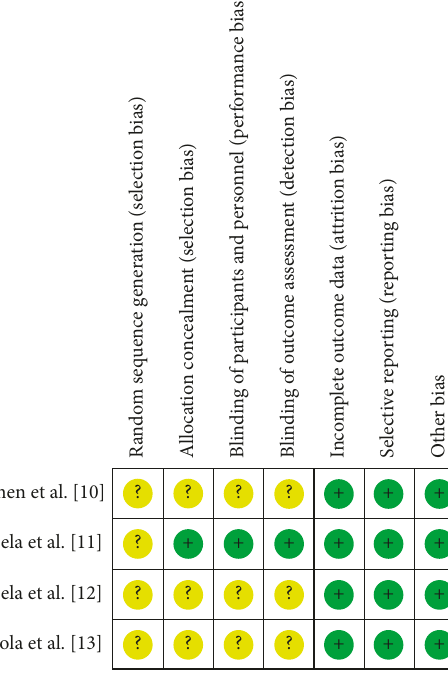
Figure 2: Risk of bias